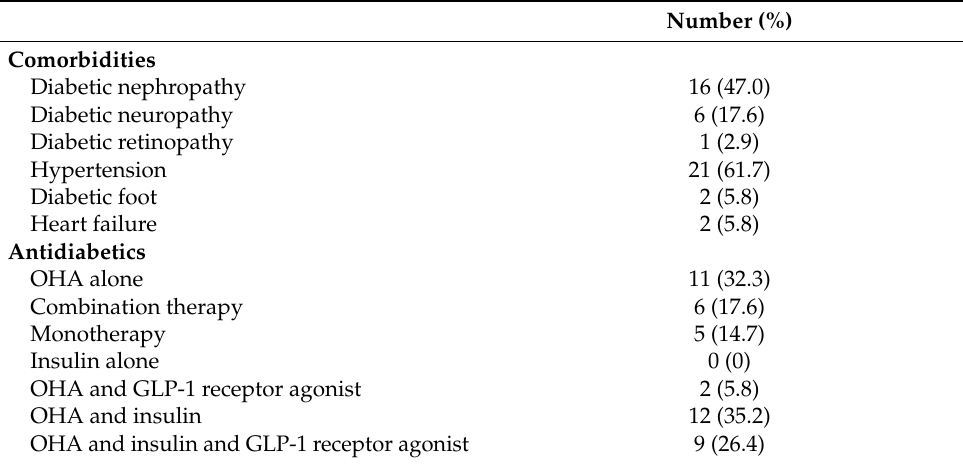
Table 3. Comorbidities and types of antidiabetic drugs prescribed for treatment of type 2 diabetes mellitus in young adults with Prader – Willi syndrome.